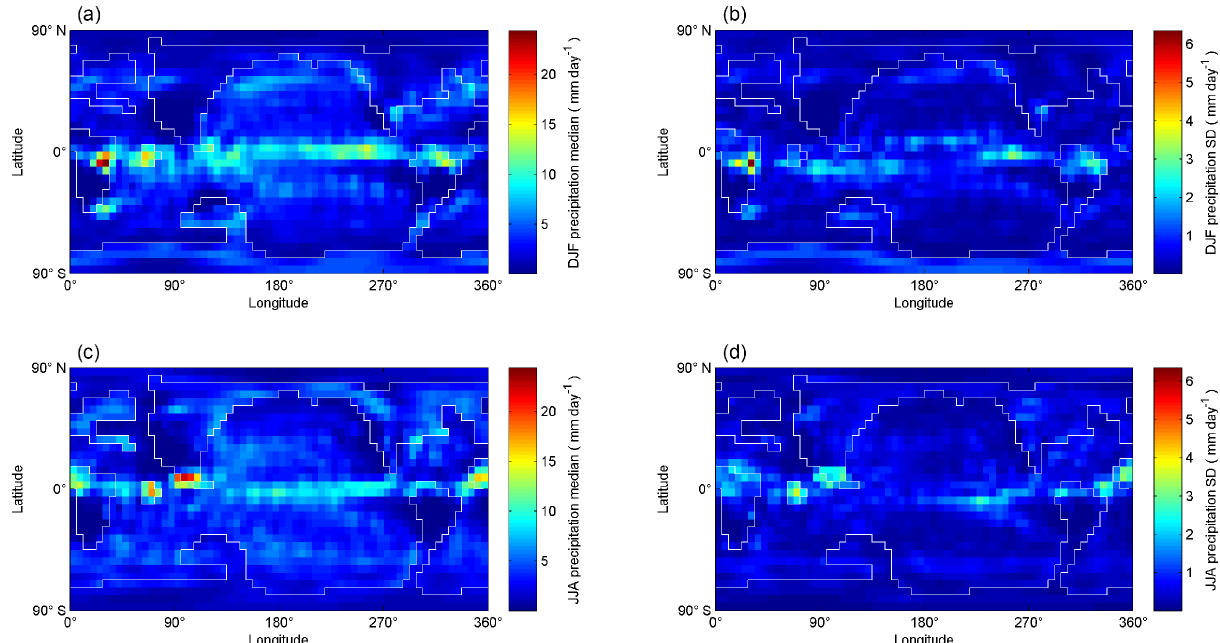
Figure 4. Ensemble precipitation medians (a, c) and standard deviations (b, d) in DJF (a, b) and JJA (c, d) .